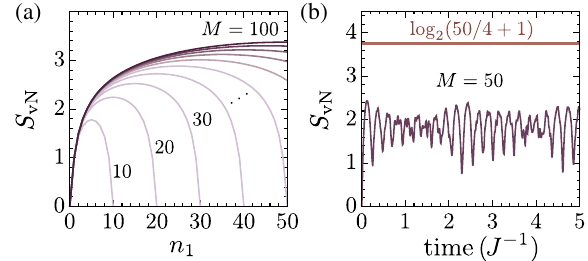
FIG. 4. (a) The half-chain entropy for single Dicke states as a function of the number of spins up and for system sizes M ¼ 10 ; . . . ; 100 . (b) The time evolution of the half-chain entropy in our specific quench experiment for a chain of 50 spins. As shown in the text, the entropy is bounded by a constant S ð M= 4 þ 1 Þ log 2